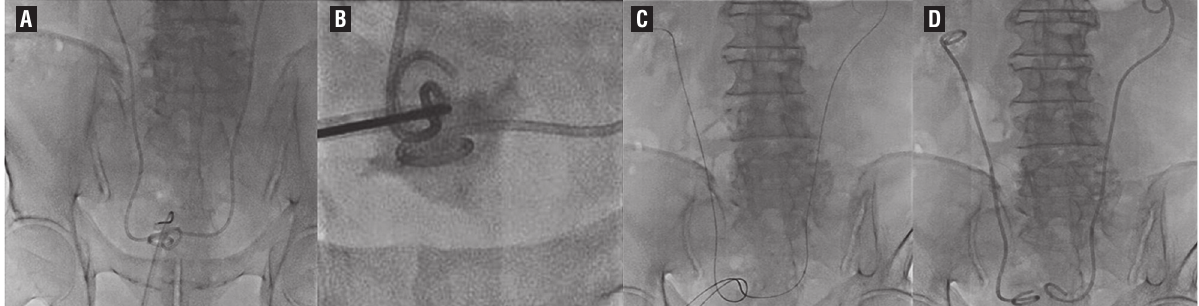
Figure 1 - Fluroscopic images of retrograde ureteral stent exchange via a cystostomy tract. A 10-F vascular sheath was introduced into the bladder (a). The bladder was distended by injection with 100mL of diluted contrast medium to prevent injury to the mucosal folds by the grasping forceps. The grasping forceps were introduced through the vascular shreath, and the tip of ureteral stent was manipulated with grasping forceps (b). The stent was gently withdrawn to just beyond the orifice of cystostomy site. A 0.035-inch guide wire (Radifocus, Terumo,Tokyo, Japan) was inserted through the ureteral stent up to the renal pelvis (c). A new ureteral stent was advanced in the retrograde direction with a pusher. Finally, the new ureteral stents were both placed